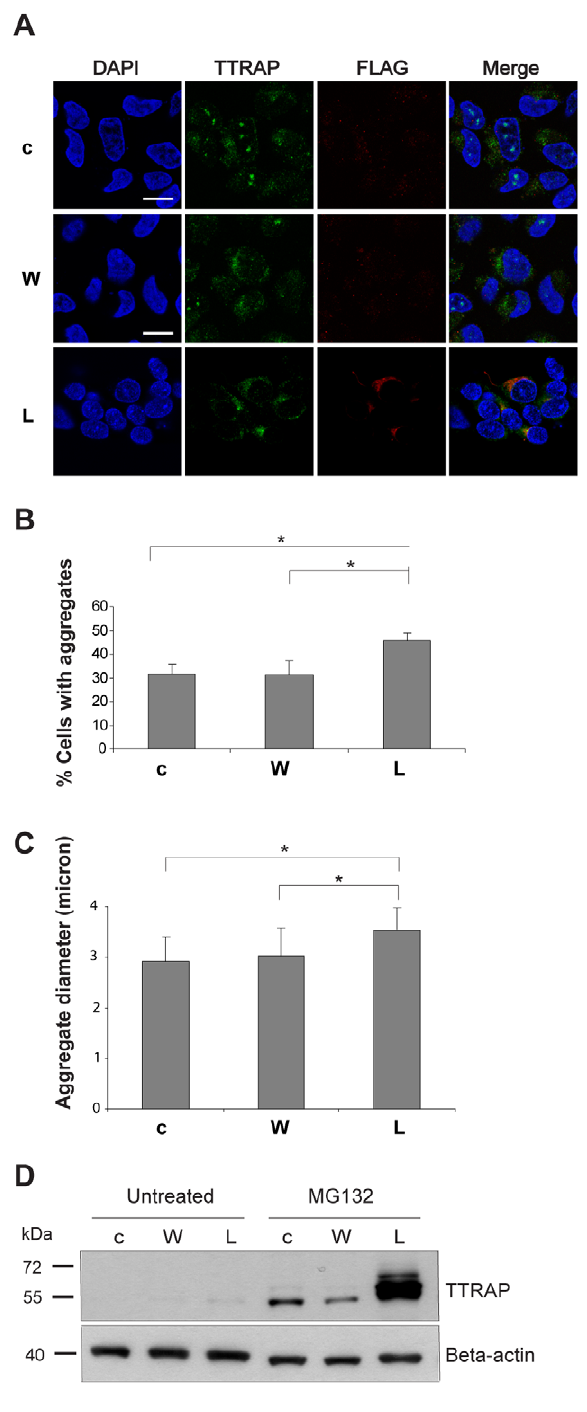
Figure 5. L166P enhances TTRAP accumulation into insoluble cytoplasmic aggresomes. (A) Cytoplasmic localization of TTRAP. SH- SY5Y cells stably expressing wt DJ-1 (W), L166P (L) or empty vector (c) were treated with 5 m M MG132 for 16 h. Before fixation, cells were permeabilized with Triton X-100 and double immunofluorescence was performed with TTRAP (green) and anti-FLAG (red) antibodies. Nuclei were visualized with DAPI. Confocal images from two independent experiments were scored for percentage of cells with aggregates (B), and aggregate average size (C). At least 50 cells per experimental condition were counted (*, p , 0.05). (D) Mutant DJ-1 L166P promotes accumulation of TTRAP in insoluble fraction. Cells were as in A. After treatment with MG132, cells were lysed, and Triton X-100 insoluble